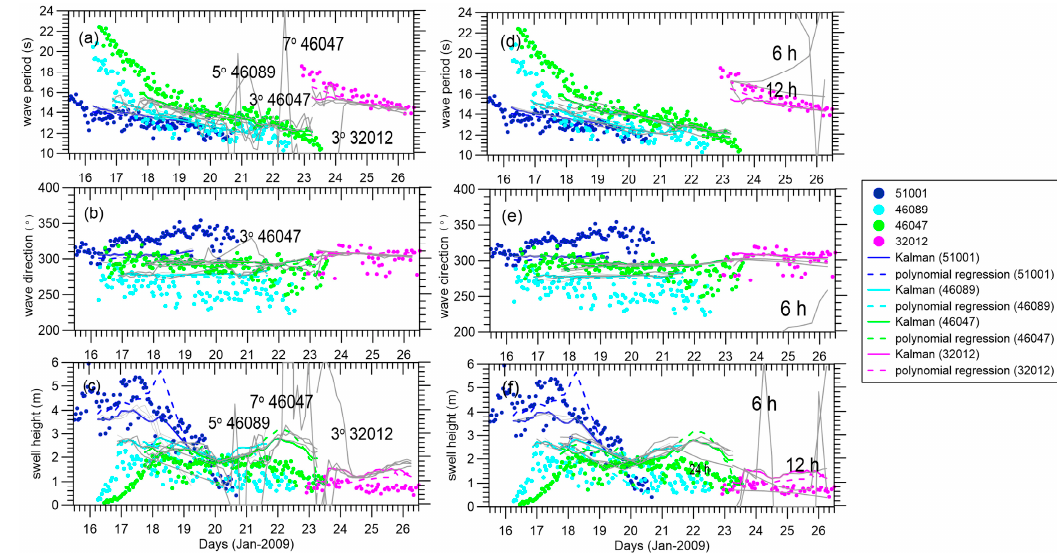
Figure 9. ( a – c ) Gray lines are EnKF results with the spatial resolution changing as follows: 3°, 5°, 7°, and 10°; ( d – f ) Gray lines are EnKF results with the time step changing as follows: 3, 6, 12, and 24 h. The EnKF, polynomial regression swell reconstruction, and tracked integral wave parameters from the buoy are the same as those in Figure 5.